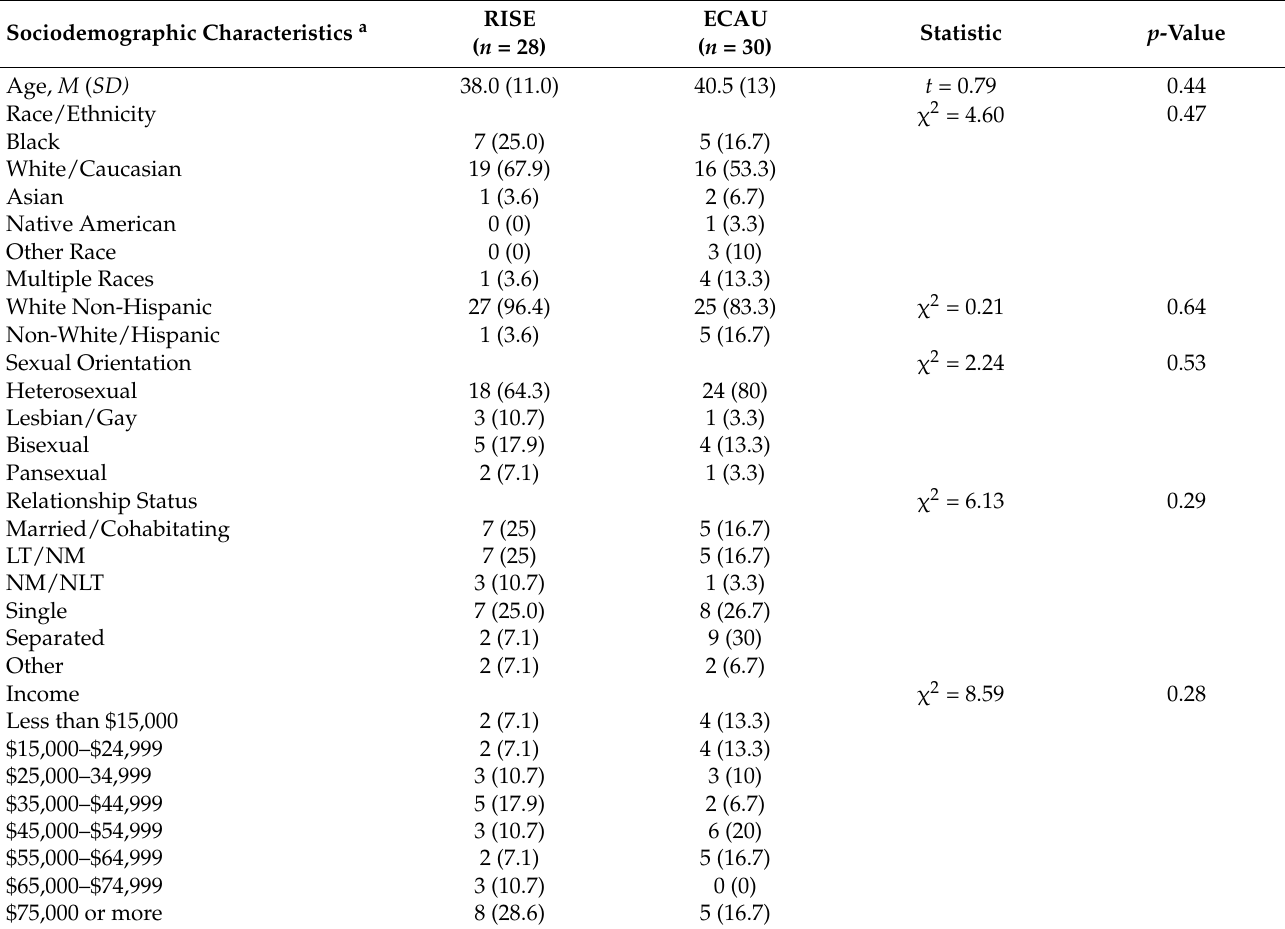
Table 1. Baseline Participant Characteristics by Condition ( N =